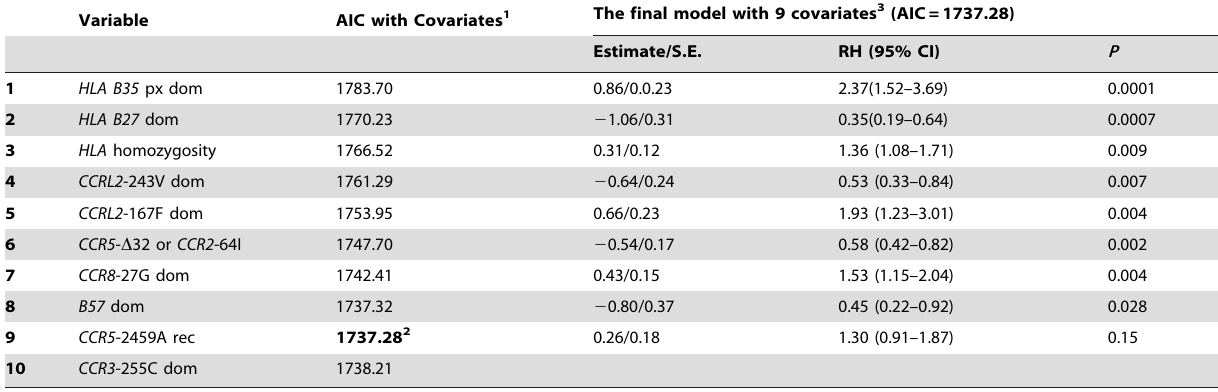
Table 3. Sequential stepwise regression for Cox PH model selection and maximum likelihood estimates of genetic covariates associated with AIDS progression.